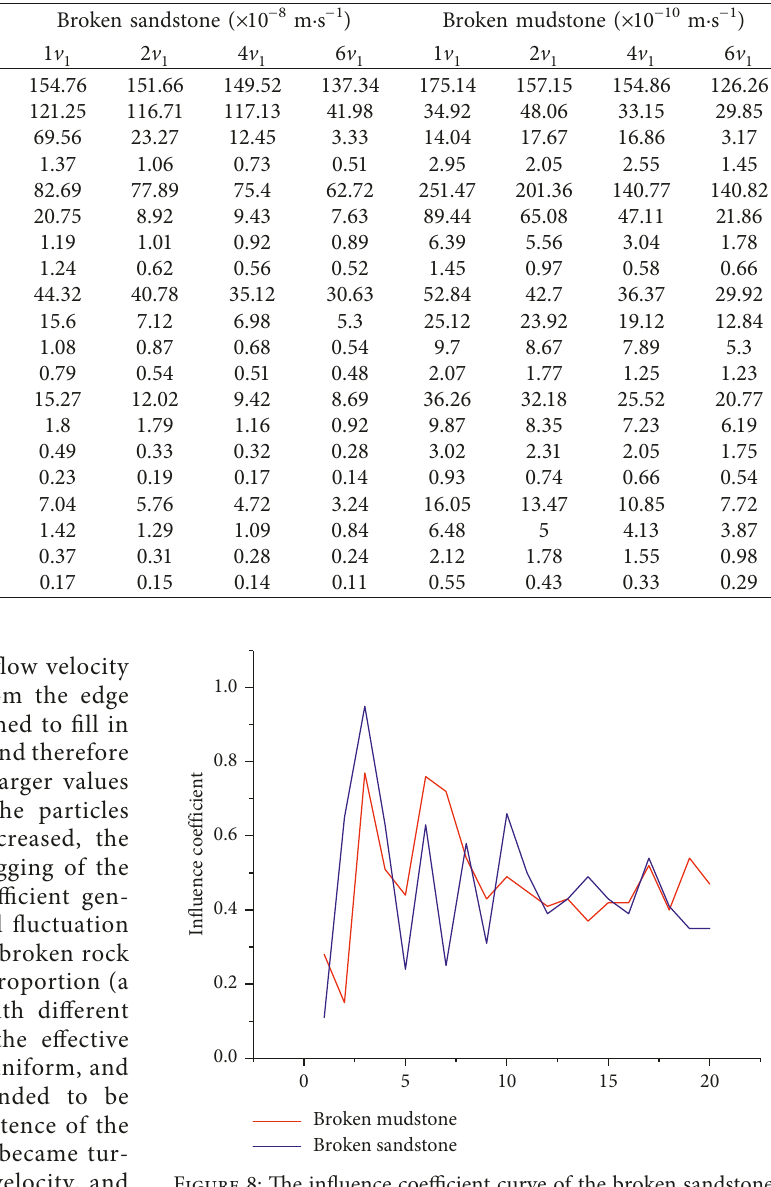
� 5.6 × 10 − 5 m · s − 1 . 1